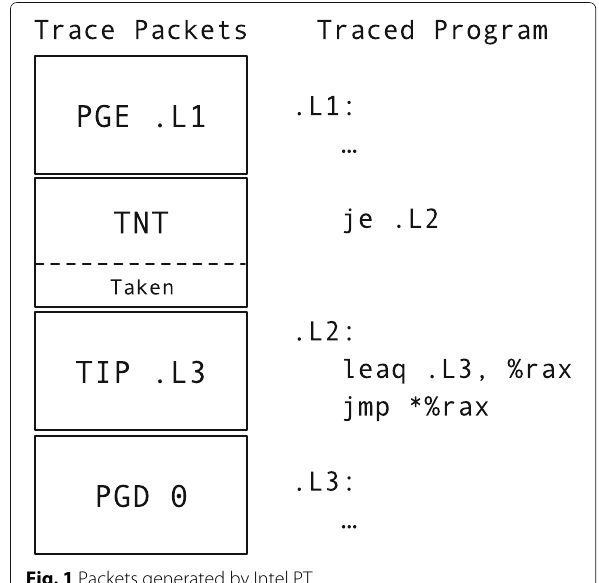
Fig. 1 Packets generated by Intel PT